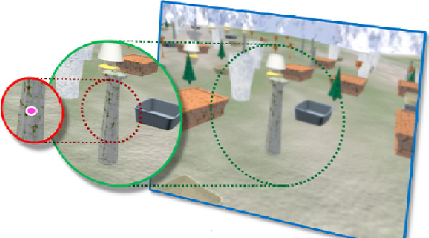
Fig. 9 Foveated 3D graphics proposed by Guenter et al. [26]. Three nested layers were rendered (red, green, and blue) at three different resolutions through rasterization based on a visual acuity fall-off model. The three nested layers are combined to generate the final image. This method could achieve comparable perceptual quality with reference to traditional full-resolution rendering, but at a 4–6.2 × speed improvement. Reproduced with permission from Ref. [26], c (cid:13) ACM 2012.